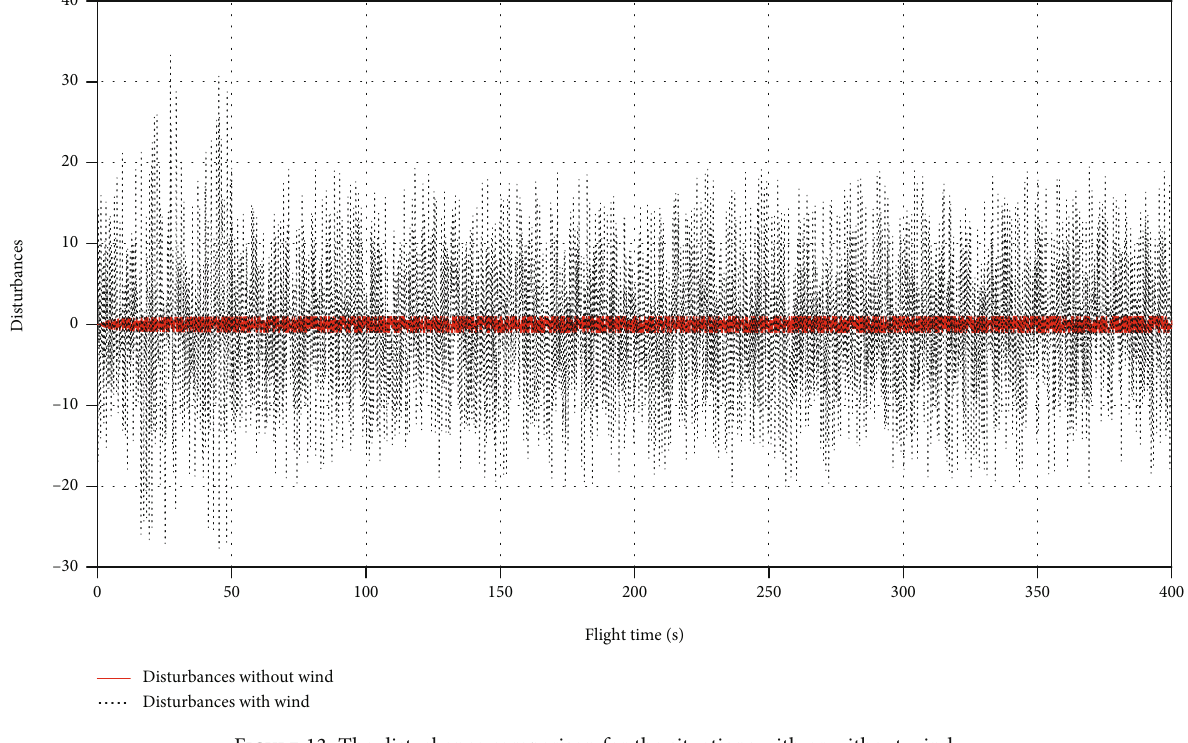
Figure 13: The disturbance comparison for the situations with or without wind.